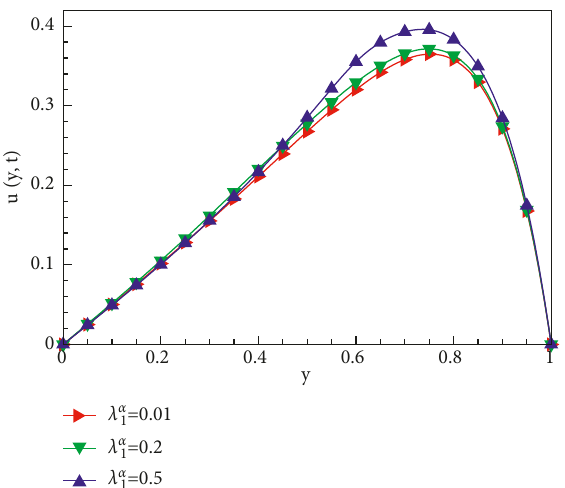
Figure 3: Influence of λ α